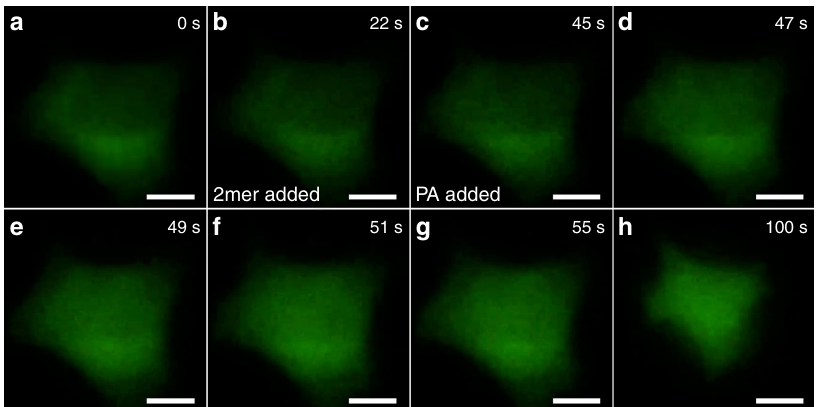
Fig. 6 Ligand-gated ion transportation of multiblock amphiphile embedded in plasma membrane. Snapshots of fl uorescence microscopic observation of L cells encapsulating Fluo-4 at 25 °C at a 0 s (at the beginning of the observation), b 22 s (after the addition of 2mer ) and c – h 45 – 100 s (after the addition of PA). Scale bars: 5.0